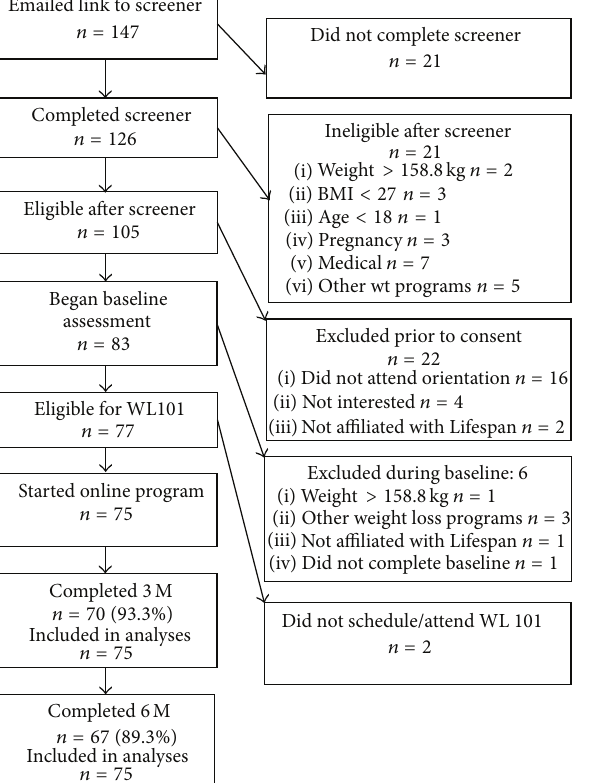
Table 1: Baseline and demographic